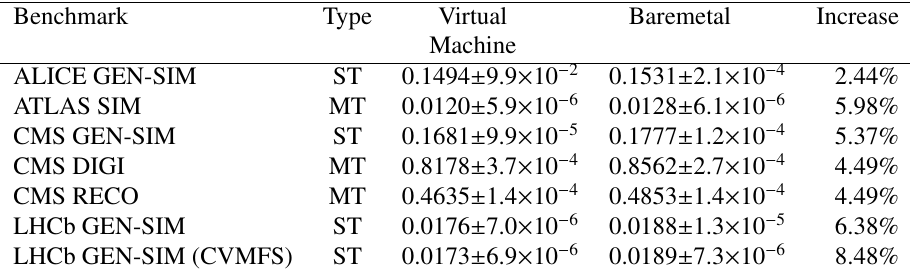
Table 2. Job throughput (events / second) improvements running the hep-workloads on baremetal compared to virtual machines. The throughput is expressed as "mean ± standard error" (ST = Single-Thread, MT = Multi-Thread)